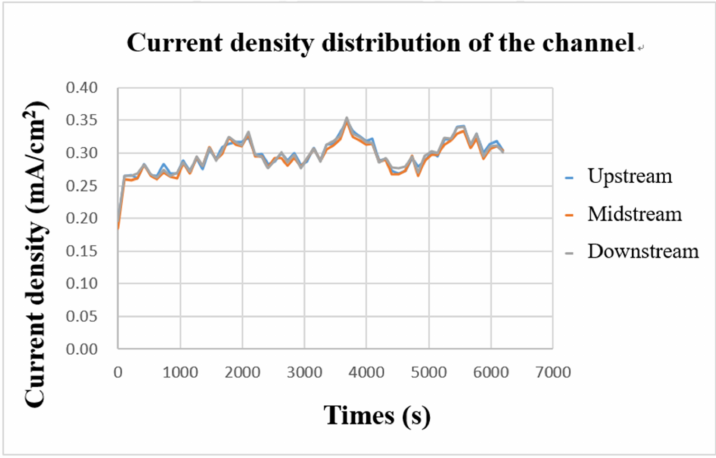
Figure 16. Charge-current-density curve of flow channel.